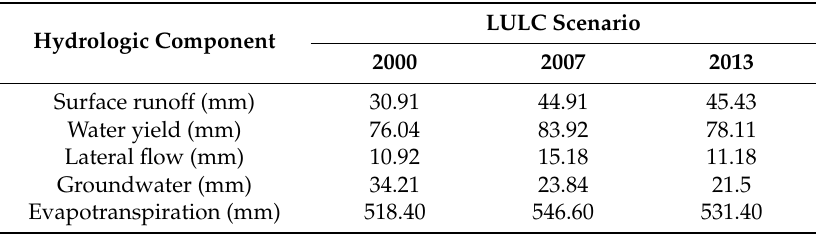
Figure 5. Average annual basin values of surface runoff, water yield, lateral flow and groundwater for three land use and land cover scenarios in the Olifants Basin. Table 7. Changes in four hydrological components based on three land use change scenarios.